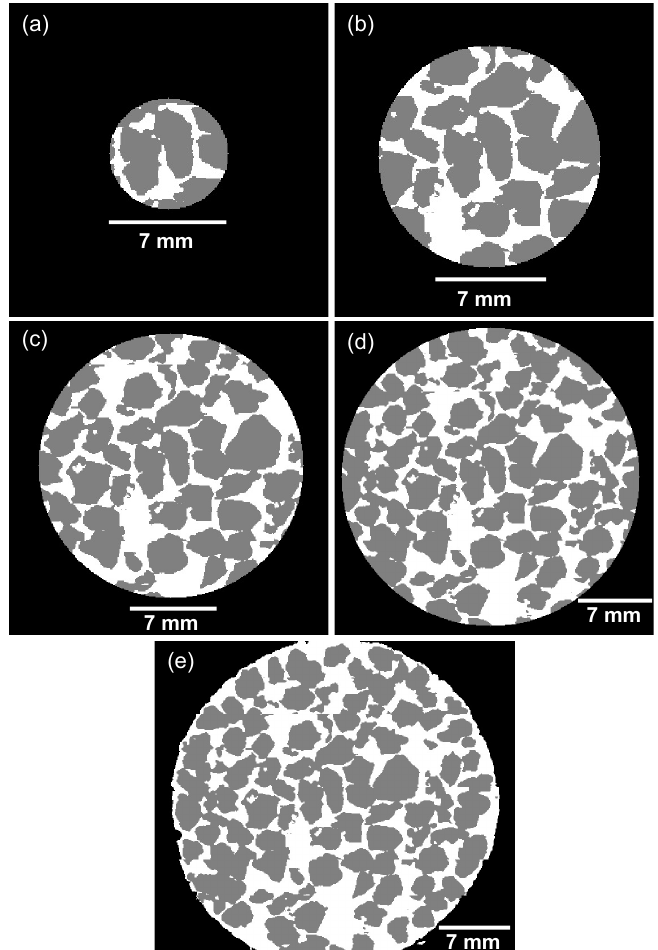
Figure 5. Sizes of the defined regions of interest: ( a ) radius of 3.5 mm, ( b ) radius of 7.1 mm, ( c ) radius of 10.6 mm, ( d ) radius of 14.1 mm, ( e ) whole